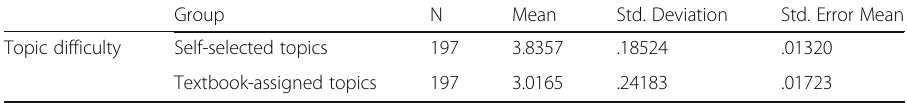
Table 15 The Mean Values of the Learner ’ s Perception of the Textbook-Assigned Topics and Self- Selected Topics Regarding the Topic Difficulty Group